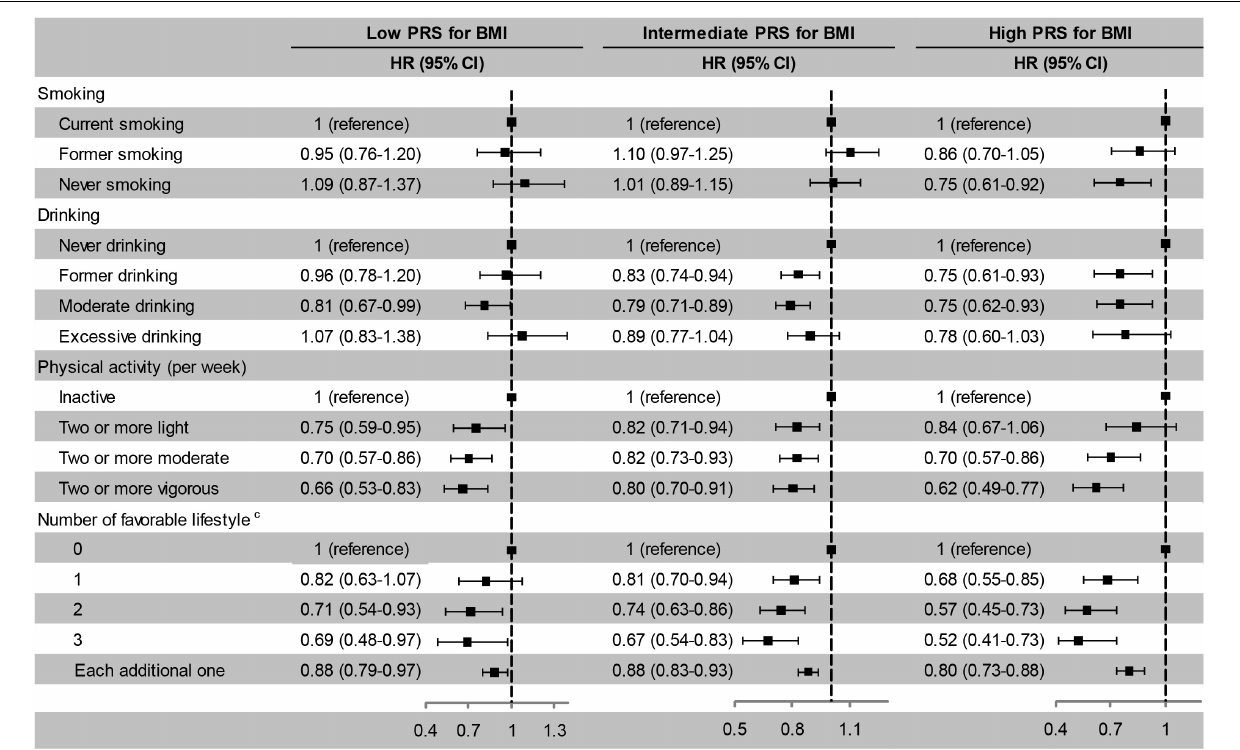
FIGURE 4 | Risk of cognitive impairment according to lifestyle stratified by PRS for BMI. The model adjusted for smoking, drinking, physical activity, baseline age, sex, education, marriage, family wealth per capita, and body weight status. c Moderate drinking was considered favourable. PRS, polygenic risk score; BMI, body mass index; HR, hazard ratio; CI, confidence interval. The significance level was set at α =